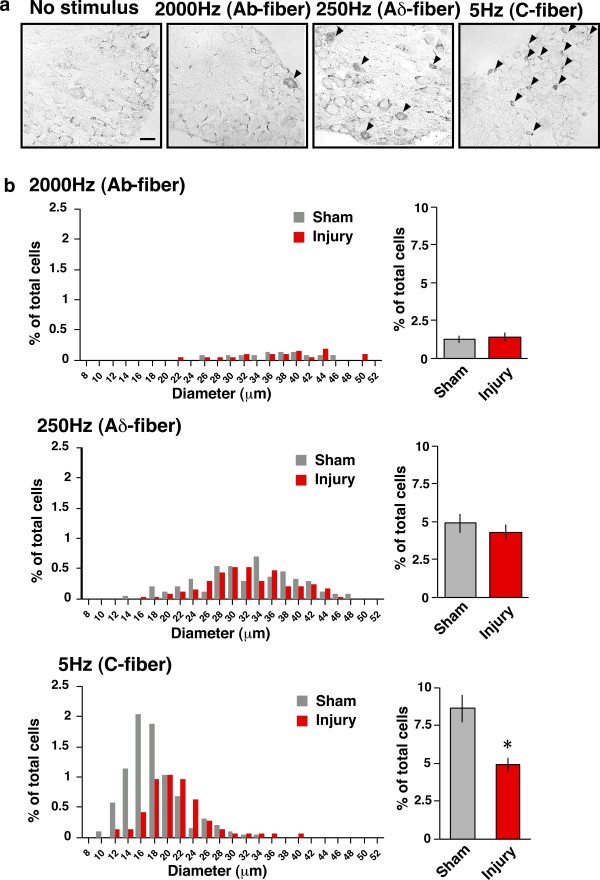
The specificity of electrical stimulation in terms of ERK phosphorylation in the DRG. (a) Representative pictures of pERK in the ipsilateral DRG after electrical stimulation to the right hind paw. Arrowheads indicate pERK-positive DRG neurons. (b) The size distribution of pERK-positive DRG cells (left panel) and its relative comparison to the total number of cells (right panel) in sham-operated and nerve-injured mice. *: p < 0.05 vs. sham. Data represent the means ± S.E.M. from experiments using at least 4 mice. Scale bar = 50 μm.